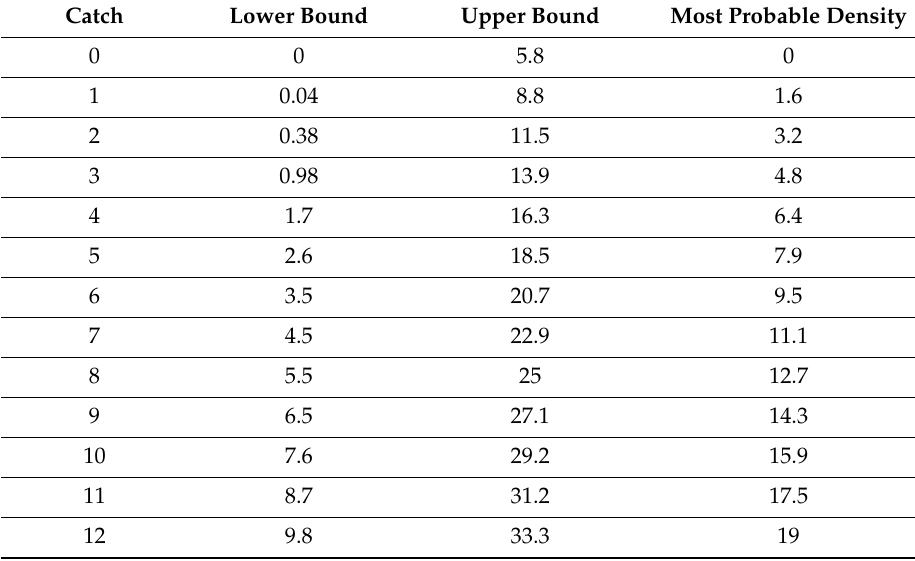
Figure 8. Estimate, based on the new model, of absolute gypsy moth male density from catch in United States Department of Agriculture milk carton pheromone-baited traps. Grey area indicates the range between lower and upper bounds with 95% probability, black line in the middle indicates the most probable density ρ mp for each specific trap catch. Table 3. Estimates of lower and upper bounds, and the most probable absolute gypsy moth male density ρ mp (males / ha) corresponding to catches in United States Department of Agriculture milk carton pheromone-baited